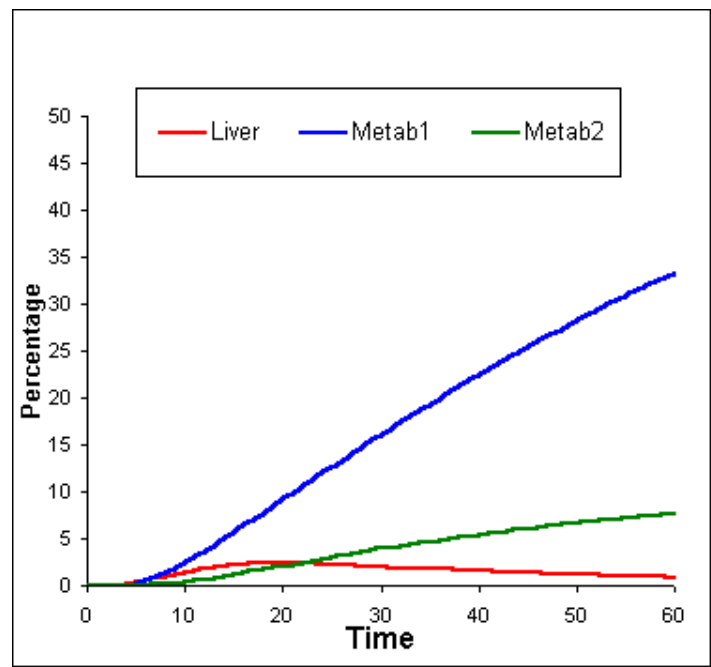
FIGURE 12 . Formation of two metabolites in the liver. Metabolite 1 has a K m value of 1 and a V max value of 1; metabolite 2 has a K m value of 10 and a V max value of 1.